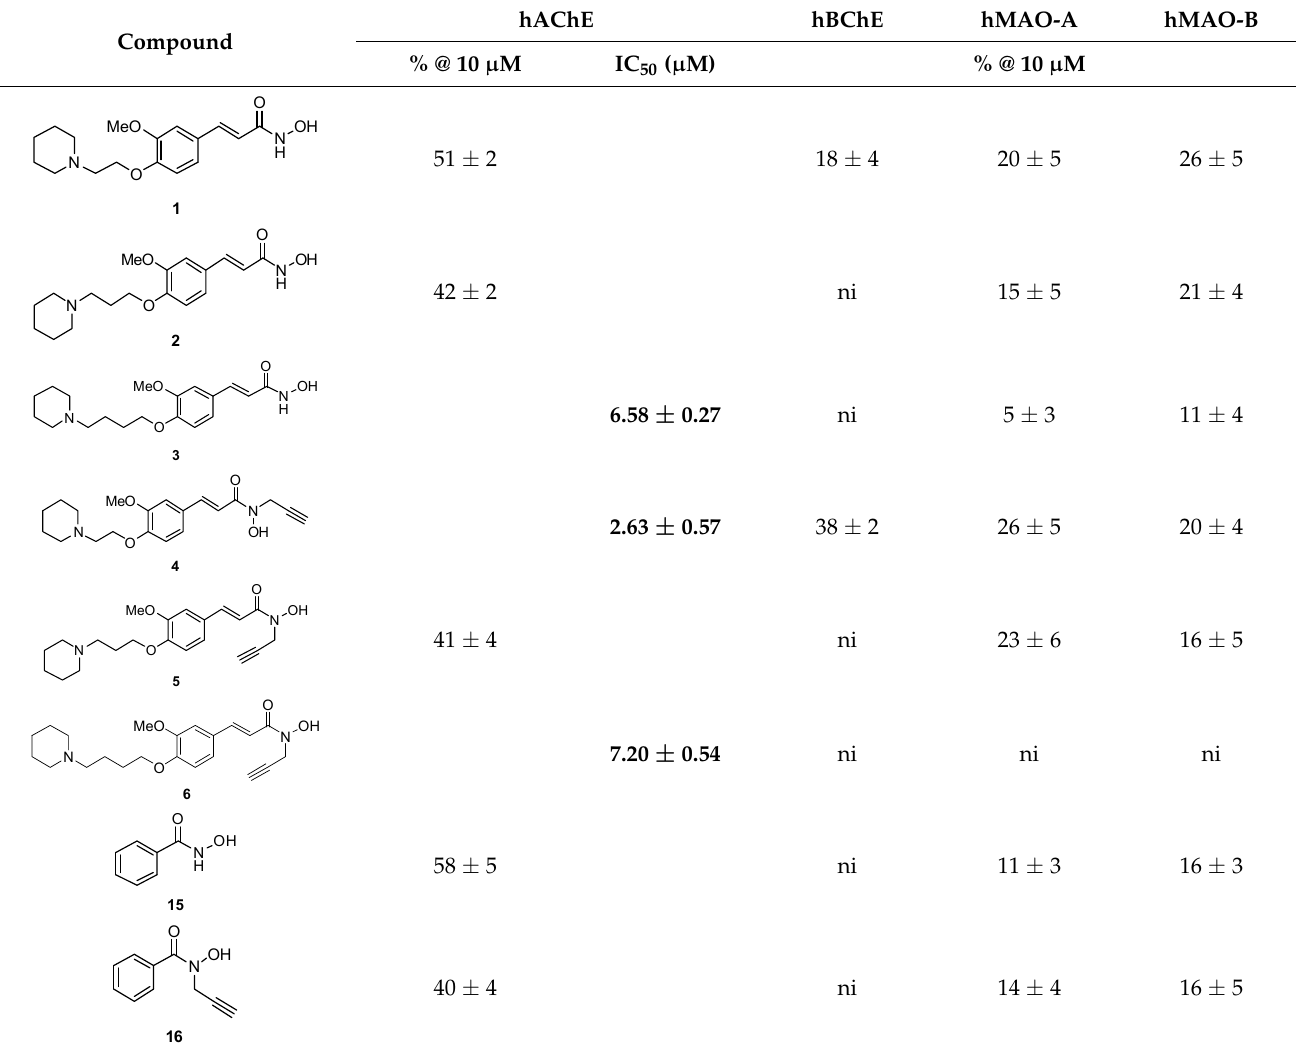
Table 1. Inhibition of FA derivatives 1 – 6 , and compounds 15 and 16 against hChEs and hMAOs. Compound